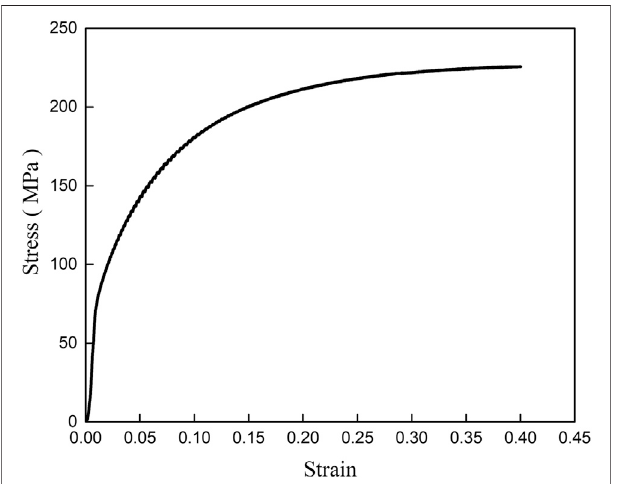
FIGURE 4 | Acceleration curve for the missile-borne